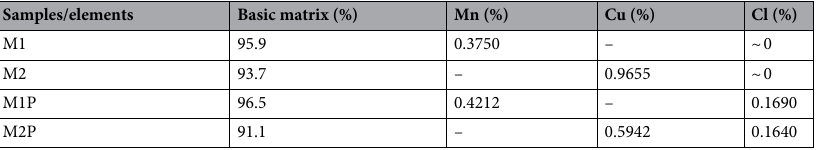
Table 2. Element components in the partial composites. % m/m—percentage of weight. PANI basic matrix: CHNO (polymer), MOF basic matrix: C